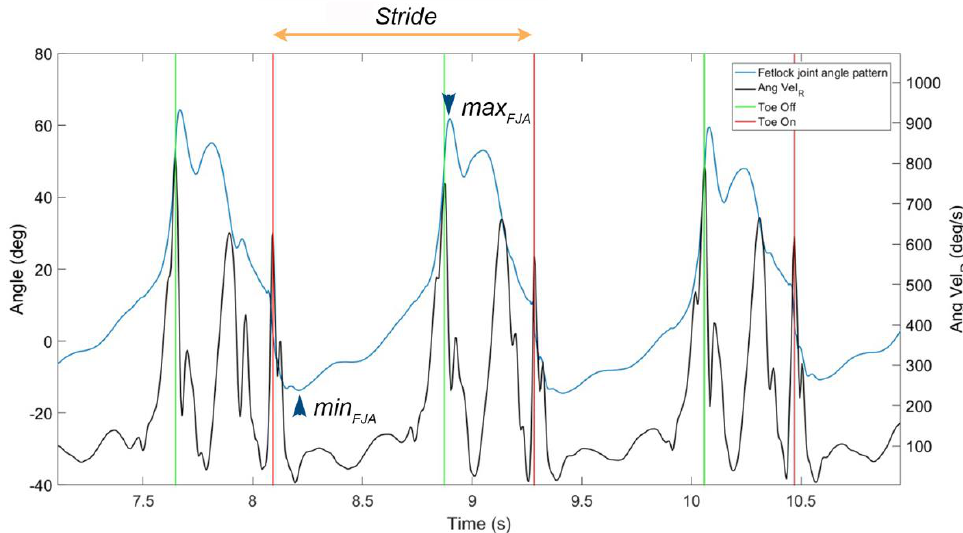
Figure 3. Results of stride segmentation by means of the gyroscope signal quantified at the pastern and identification of minimal and maximal FJA during the stride used for calculation of fetlock joint range of motion (FJROM). Data from a lame horse at walking speed on asphalt. Ang vel R : resultant angular veolcty; min FJA : minimal FJA within the stride; max FJA : maximal FJA within the